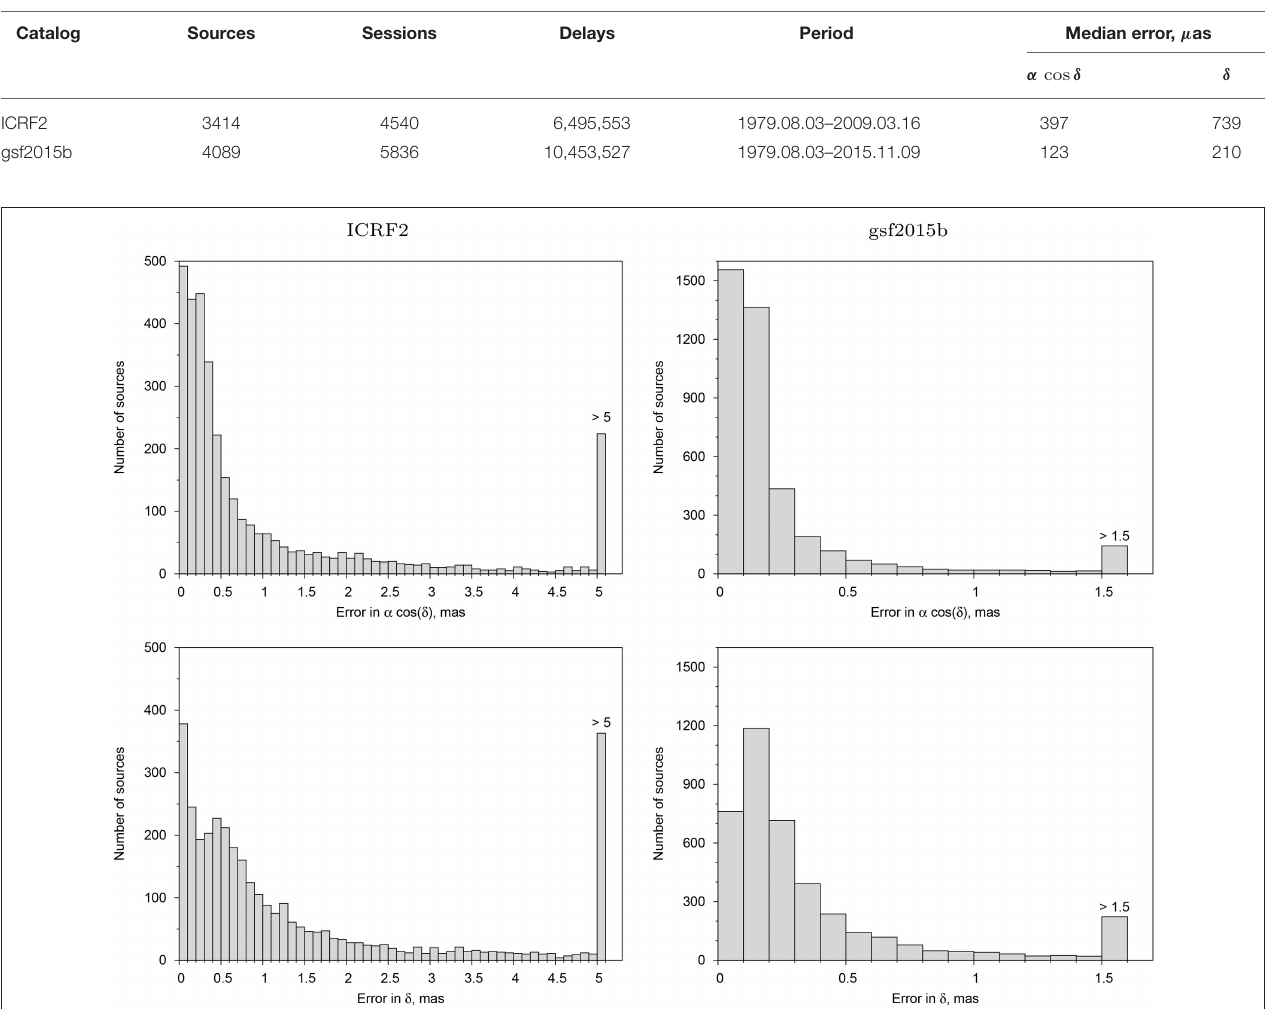
TABLE 1 | Basic statistics of the ICRF2 and gsf2015b catalogs.